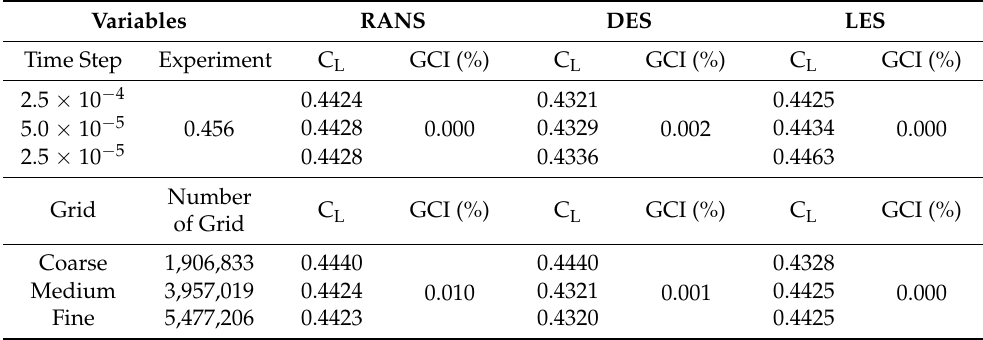
Table 3. Grid Convergence Index (GCI) of lift coefficient according to turbulence models and time